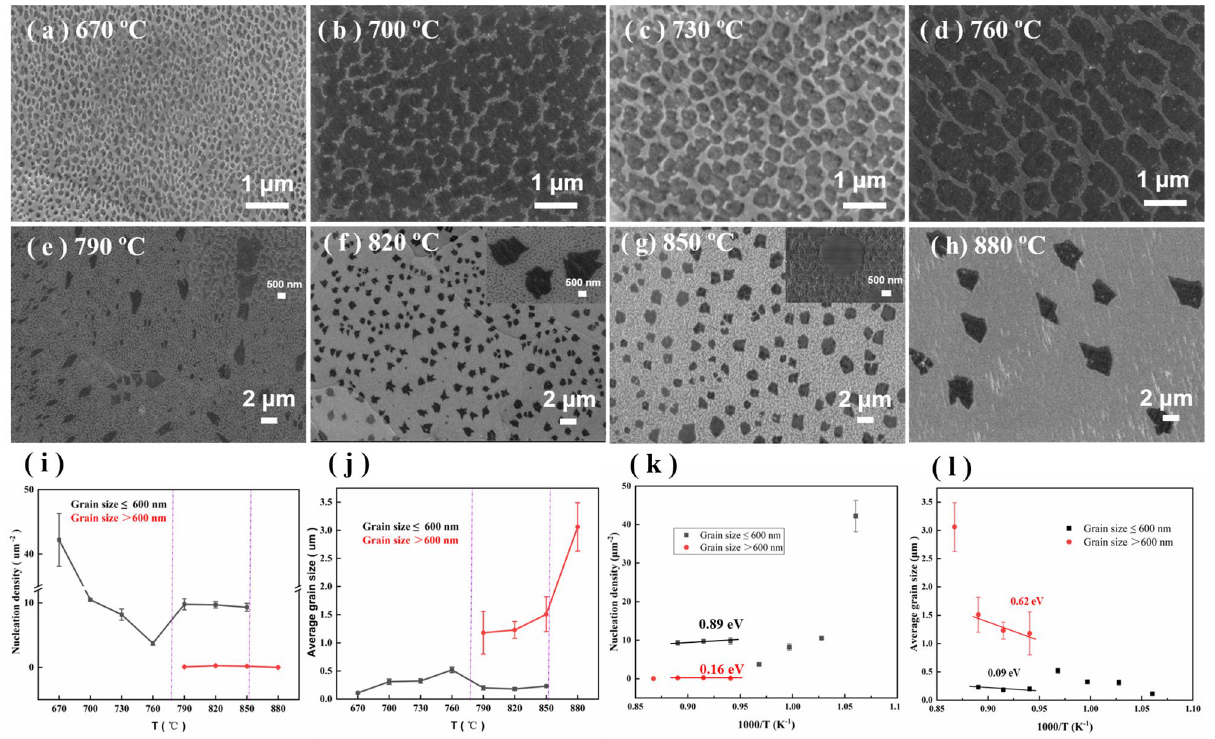
Figure 4. ( a – h ) SEM images of graphene grown on polished Cu at different temperatures from 670 °C to 880 °C for 60 s. The plasma power was 50 W. The ( i ) nucleation density and ( j ) grain size of graphene with the growth temperature. Arrhenius plots of the ( k ) nucleation density and ( l ) average grain size (the black line represents graphene grains < 600 nm and the red line represents grains > 600